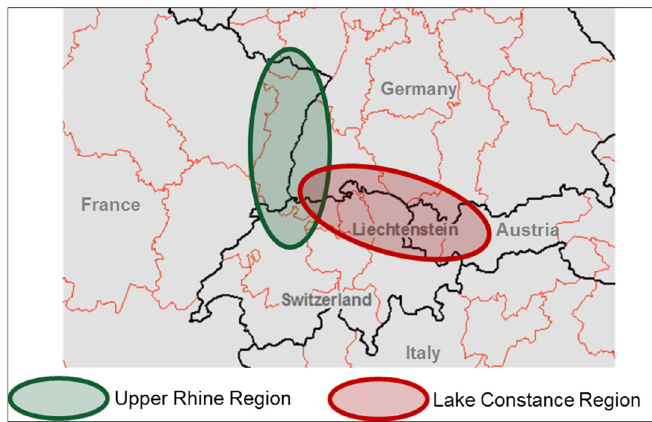
Figure 2. The two case regions. Source: Authors’ own